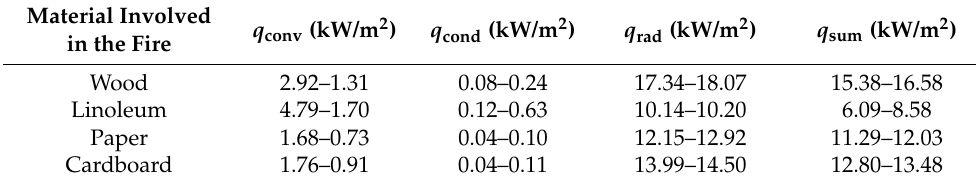
Table 4. Variation ranges of specific heat flux densities for different types of fires.